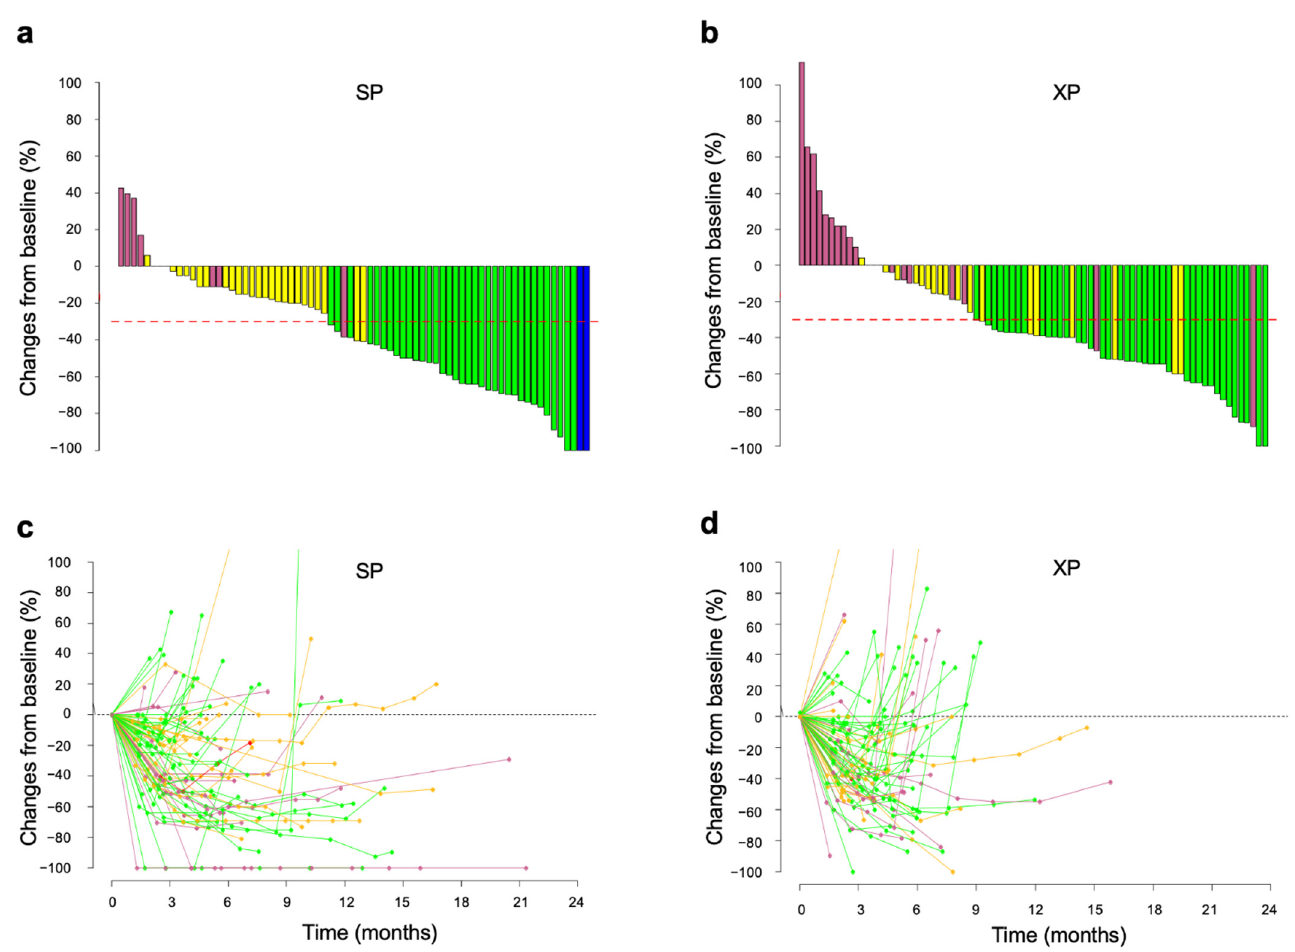
Figure 2. Changes in tumor size during treatment with SP or XP. ( a , b ) Best change from baseline in the sum of the longest target lesion diameters for each patient receiving SP ( a ) or XP ( b ). Best responses are color-coded: blue, CR; green, PR; yellow, SD; pink, PD. Red dashed lines indicate tumor shrinkage of 30%. ( c , d ) Time course of the percentage change in the sum of the longest target lesion diameters from baseline in each patient receiving SP ( c ) or XP ( d ).